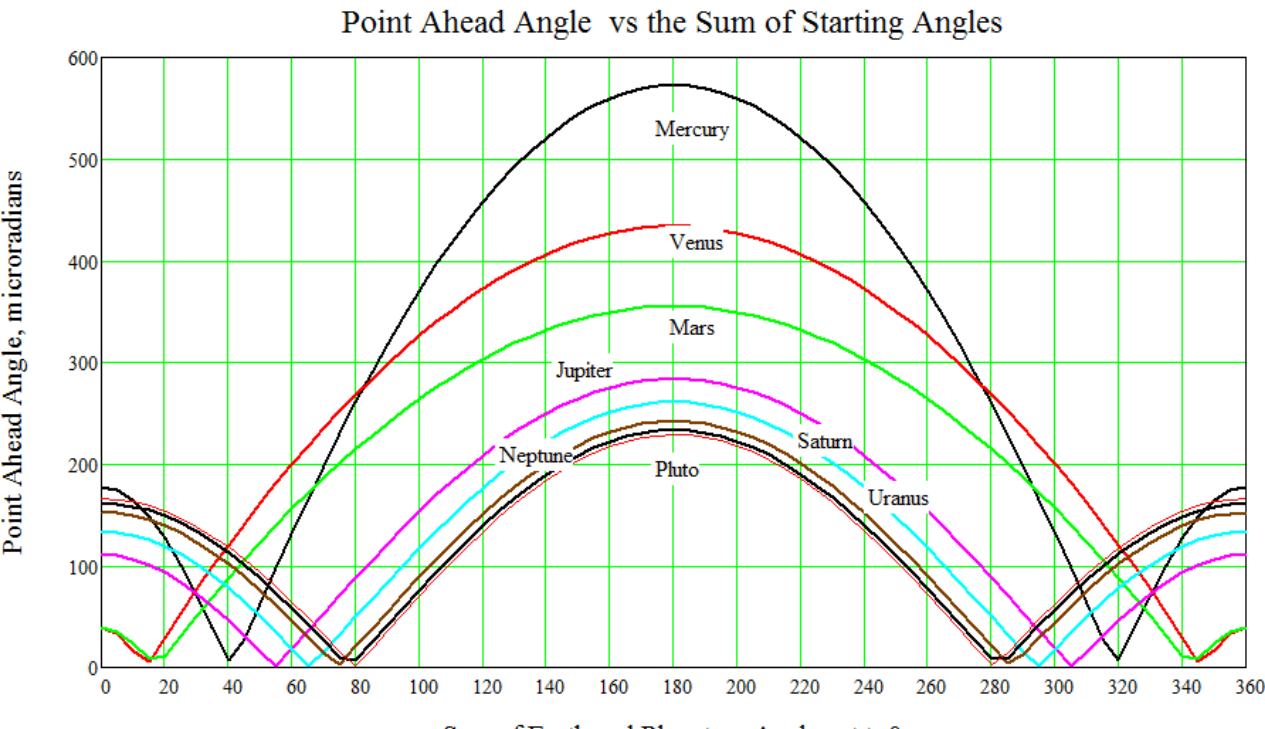
Figure 6. Terminal point ahead angles in microradians for the various planets in the solar system versus the sum of their angular positions in their orbits about the Sun. Maximum point ahead angle occurs when Earth and the planet are on opposite sides of the Sun (180°) due to the fact that: (1) the range between them, and therefore the light travel time, is maximized; and (2) their orbital velocities I are in opposite directions and therefore the relative velocity is additive. The point ahead angles decrease for the outer planets because of their slower orbital angular velocities. Smaller secondary peaks occur at 0° (or 360°) for all the planets because: (1) the orbital velocities are in the same direction and therefore the relative velocity is reduced; and (2) the light travel time is minimized. Intermediate angles where the point ahead angle drops to near zero would be advantageous for mutual acquisition of the two terminals and occur twice per Earth year.